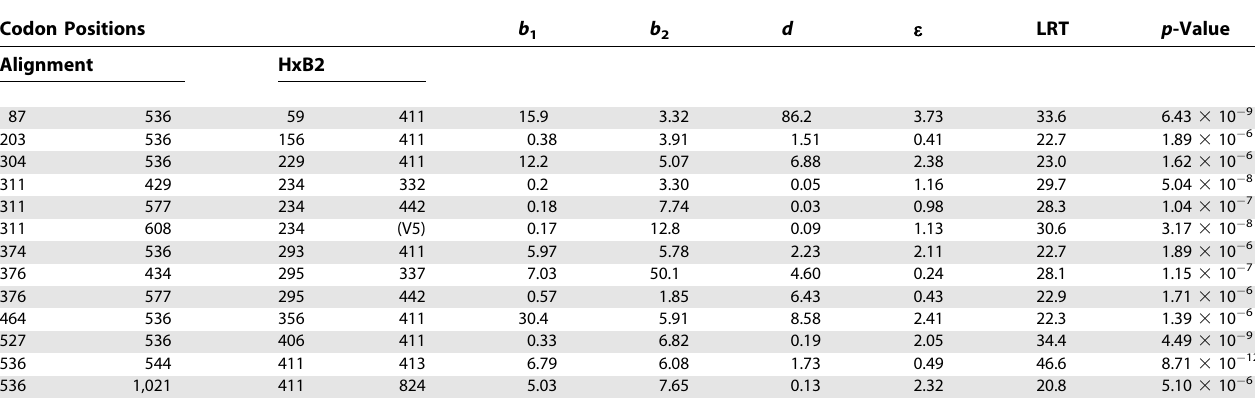
Table 1. Parameter Estimates for Nonoverlapping PNGSs with Significant Interactions in the Disequon Model Codon Positions